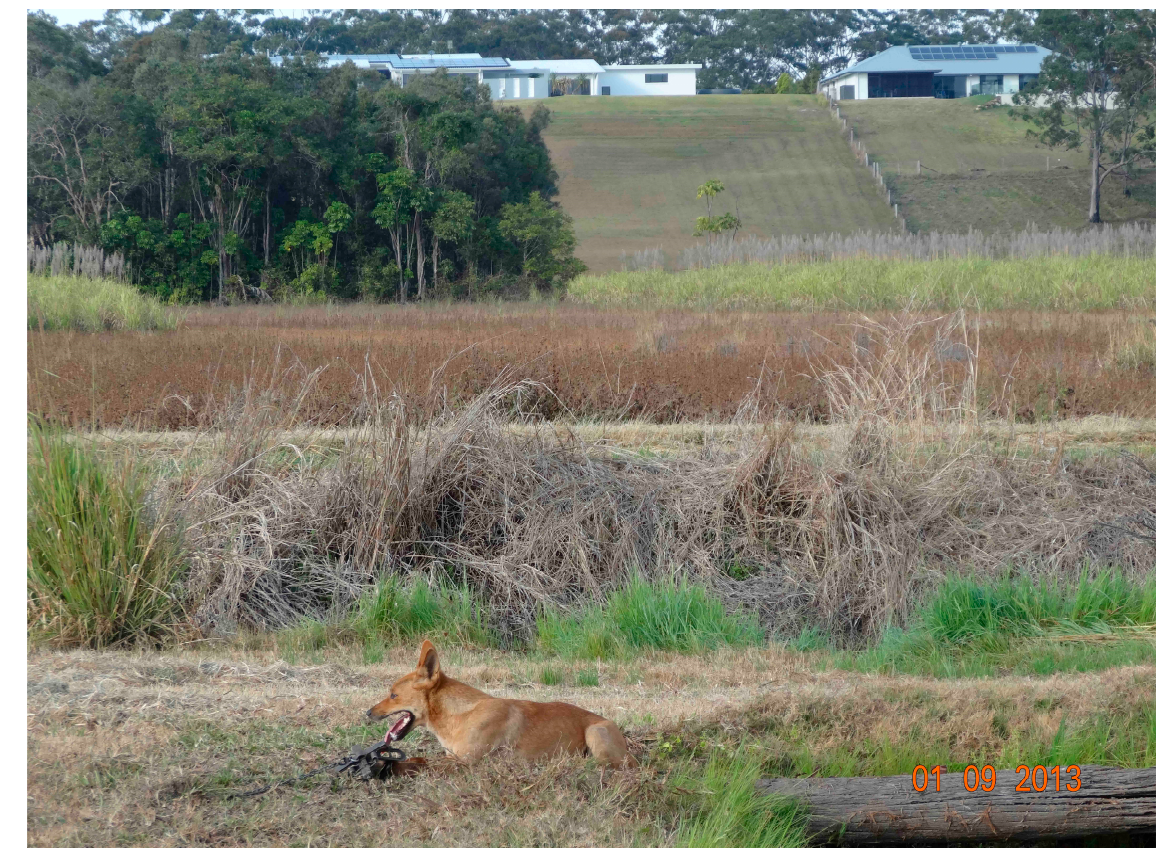
Figure A5. An urban wild dingo. This photograph was taken in September 2013 in a sugarcane field at Bli Bli on the Sunshine Coast, south-eastern Queensland. Note the proximity of residential housing. The dingo is caught in a soft-catch foothold trap, which prevents injury. This individual was fitted with a GPS collar and released unharmed as part of an urban wild dingo tracking study. Credit: Benjamin